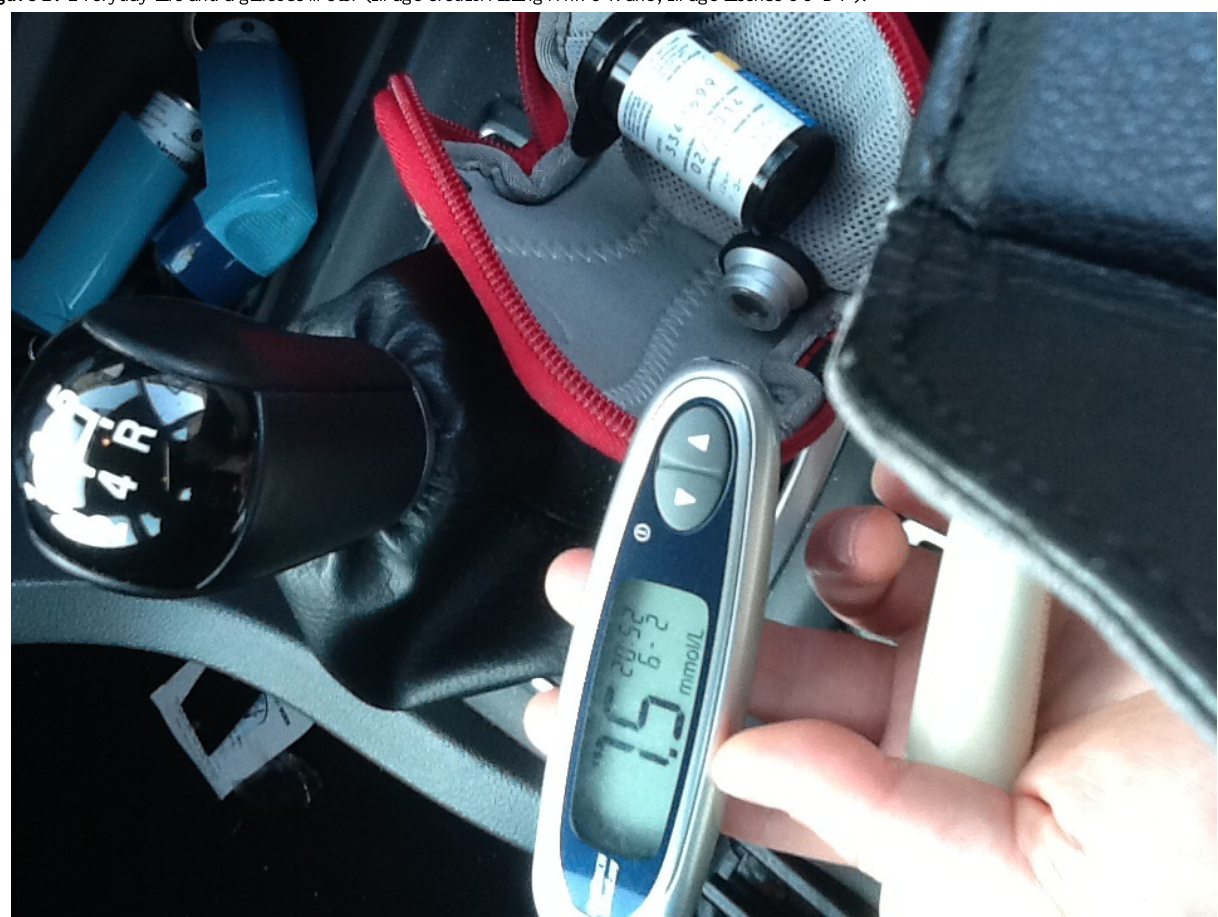
Figure 2. Everyday life and a glucose meter (image credit Aisling Ann O'Kane; image license